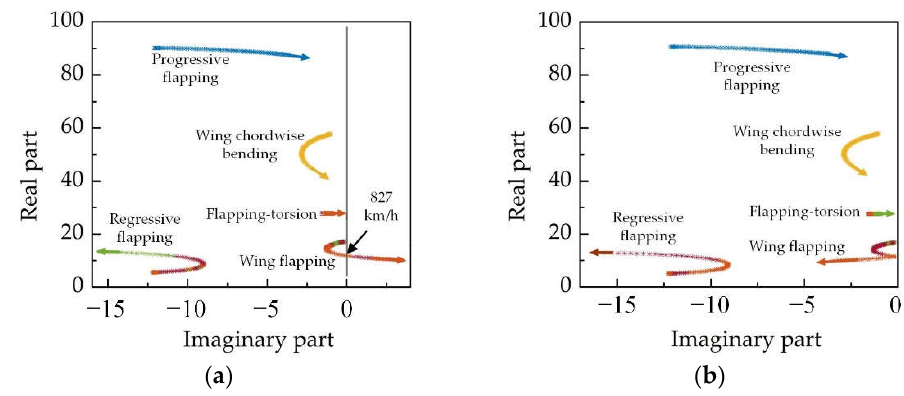
Figure 10. Root locus of the semi-span model: ( a ) with controller off; ( b ) with controller on.